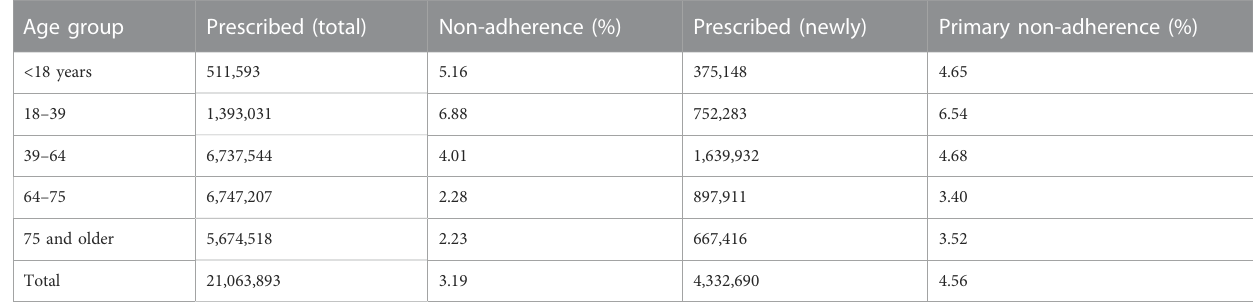
TABLE 3 Issued and collected electronic prescriptions in the studied sample — non-adherence and primary non-adherence in the age groups. Age group